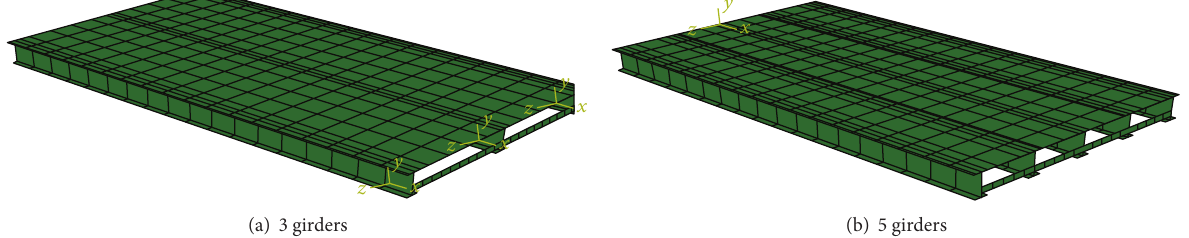
Figure 3: Finite element model of the composite bridges.